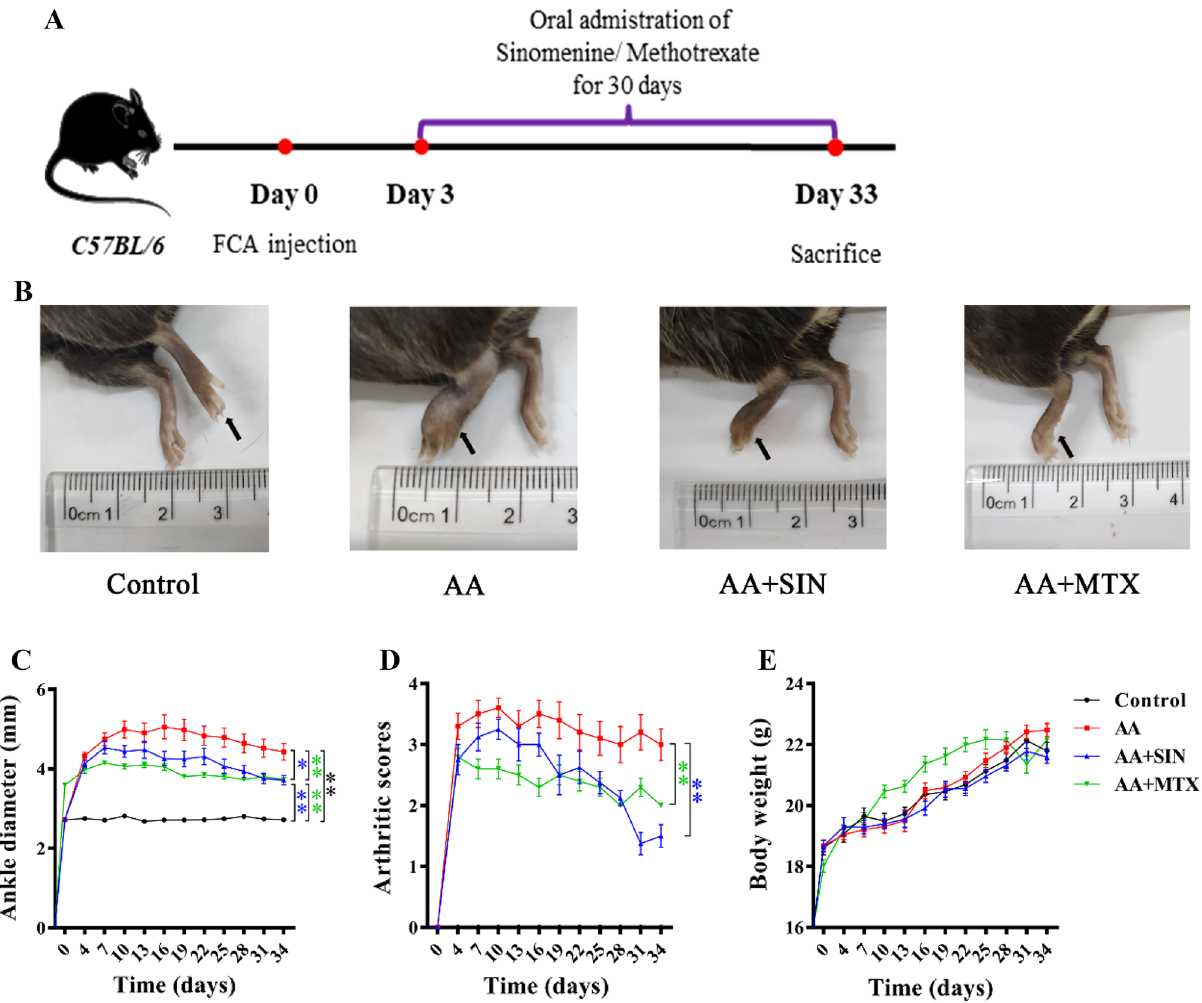
Figure 1. Sinomenine reduced ankle joint swelling and arthritis scores in AA mice. ( A ) Schematic diagram of the animal experiment. ( B ) Representative pictures of the hind paws of the mice on Day 33. The left hind paws are indicated by black arrows. ( C ) The diameter of the ankle joint was measured every three days. The data are shown as the mean ± SD (n = 10). ( D ) The severity of arthritis was scored 0–4. The data are shown as the mean ± SD (n = 10). ( E ) The bodyweight of the mice was monitored. The data are shown as the mean ± SD (n = 10). Control, AA, AA + SIN and AA + MTX indicate the control group, the AA model group, the Sinomenine treatment group and the methotrexate treatment group, respectively. *p < 0.05; **p < 0.01